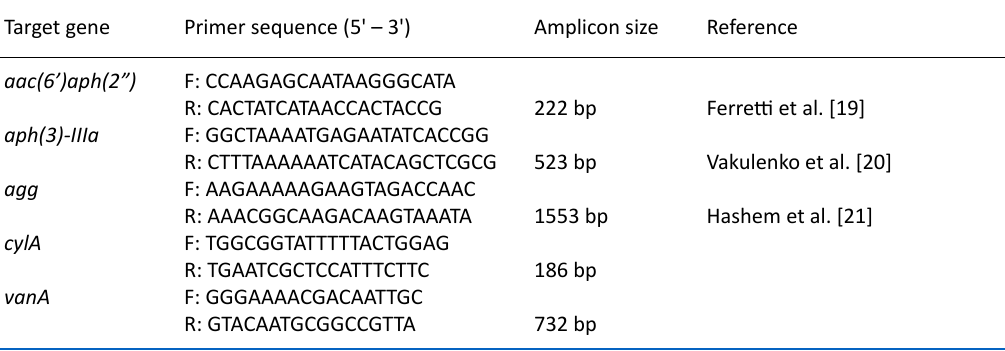
Table 1. PCR oligonucleotide primers used in the study Target gene Primer sequence (5' –